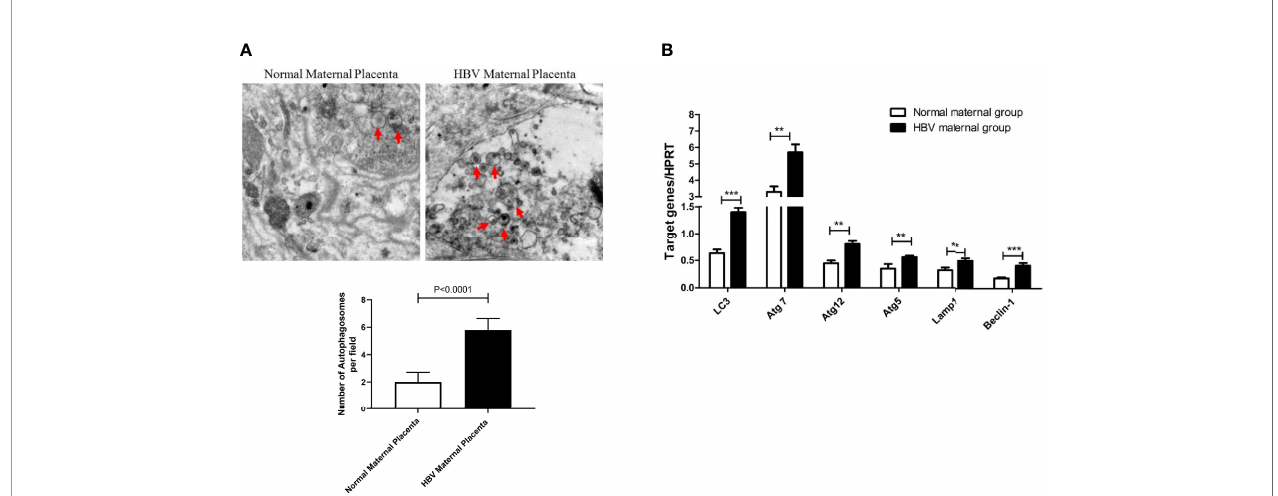
FIGURE 1 | Differential expression of autophagy markers between the placenta of normal and HBV-positive pregnant women. (***p<0.001, **p<0.01). (A) The number of autophagosomes was detected by electron microscopy, the autophagosomes were indicated by red arrows and quanti fi ed by randomly selecting and screening 100 fi elds for two samples in the normal maternal group and two samples in the HBV maternal group. The representative images from the normal maternal group and HBV maternal group are shown. (B) mRNA expression of LC3, ATG7, ATG12, ATG5, Lamp1, Beclin-1 was measured by qPCR between the normal maternal group (25 cases) and HBV maternal group (144 cases). Data are shown as mean ± SD of at least three independent